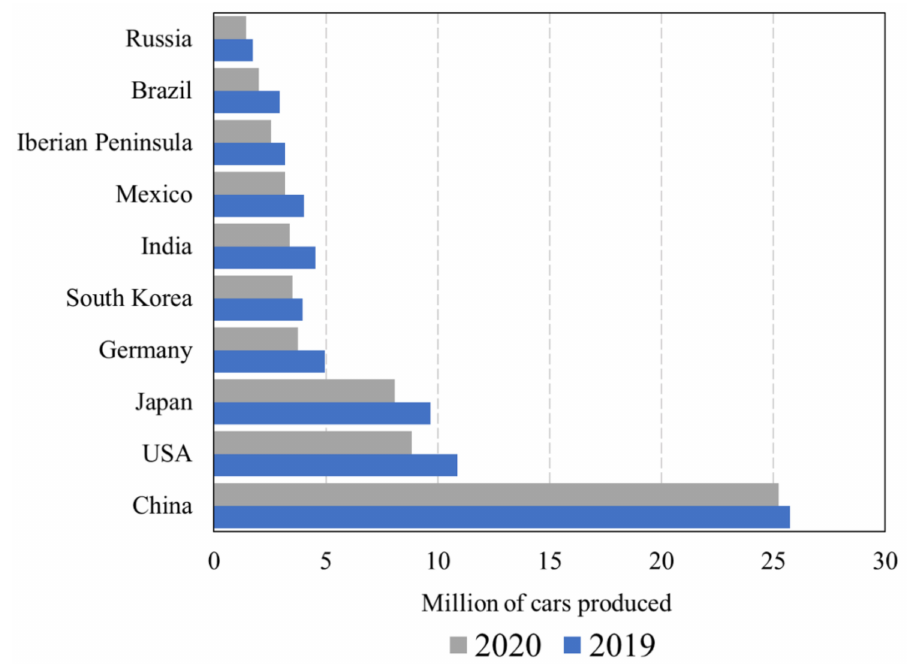
Figure 1. Vehicle production by country in 2019 and 2020 years (Source: Own elaboration based on OICA (International Organization of Motor Vehicle Manufacturers) statistics